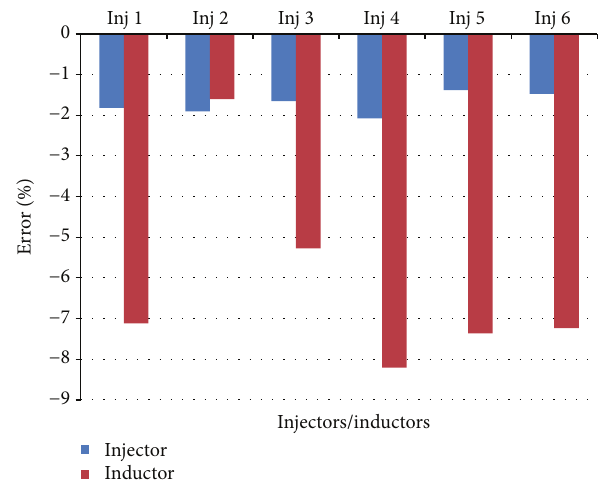
Figure 6: Mean error (%) using double threshold.